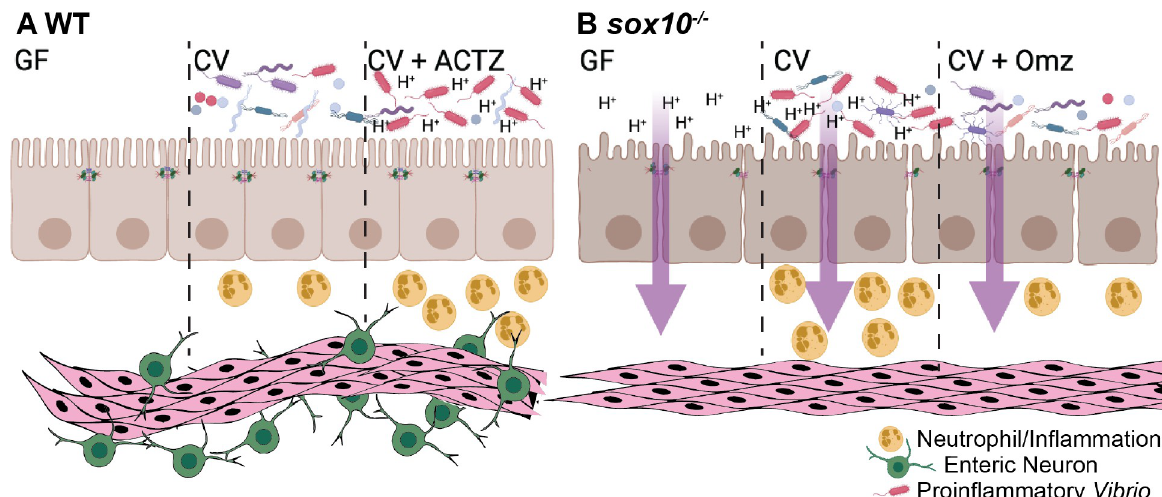
Fig 7. Proposed model of luminal pH driven intestinal pathology. (A) WT larvae with an ENS maintain luminal pH in GF and CV conditions. WT CV larvae maintain a healthy balance of microbiota and surveying neutrophils. ACTZ treatment of CV WT larvae decreases luminal pH, driving increased proinflammatory Vibrio abundance and neutrophil influx. (B) sox10 mutants lacking the ENS have decreased intestinal transit, hyperpermeability, and decreased luminal pH in both GF and CV conditions. Decreased luminal pH promotes an increase in proinflammatory Vibrio leading to increased neutrophils and a hyper-inflammatory state. Omz treatment to CV sox10 mutants increases luminal pH, resulting in decreased Vibrio abundance and ameliorated hyperinflammation. Model created with BioRender.com.